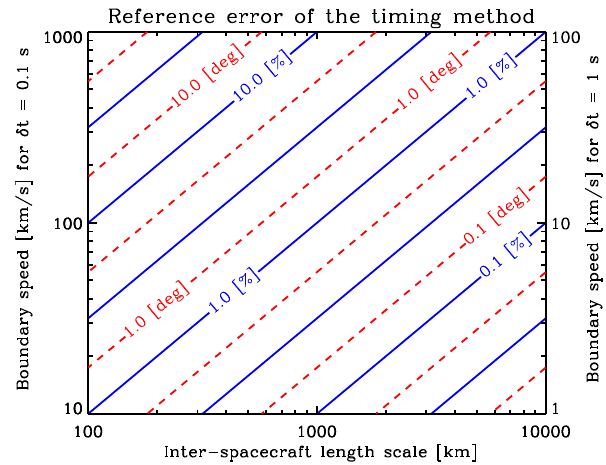
Fig. 1. Influence of array geometry on the accuracy of the tim- ing method: reference error V δt/L . Blue and solid contour lines give the relative error in boundary speed δV/V in percent. Red and dashed contour lines give the directional uncertainty δθ in de- grees. Control variables are the inter-spacecraft length scale L and the boundary speed both for crossing time inaccuracies δt = 0 . 1s (annotation at the left y-axis) and δt = 1s (annotation at the right y-axis). The spacing of the contour lines is